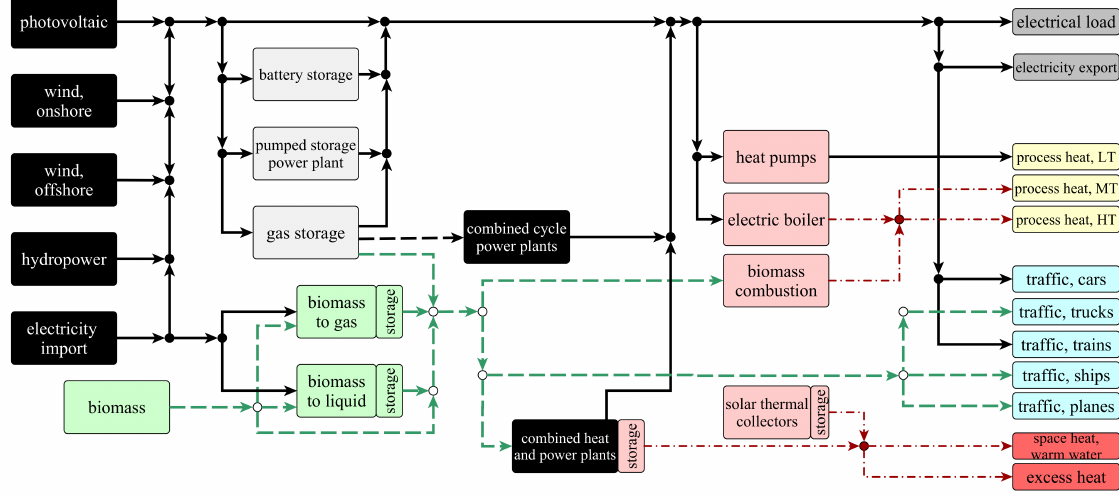
Figure 1. The figure shows the topology of one possible system constellation using the UCB-SEnMod energy model. The colors of the blocks indicate different facilities, technologies, and consumption units. For example, the black blocks represent the core of the system: the power generation plants and the import and export of the electricity import. The coloring of the arrows symbolizes the type of energy flow: black for electricity, red for heat, and green for